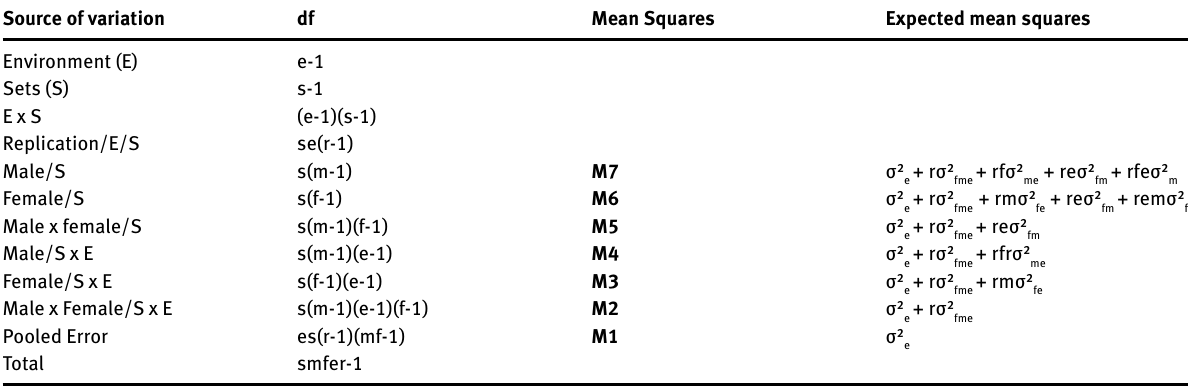
Table 2: Analysis of variance of Mating Design II North Caroline, over environments for model II Source of variation